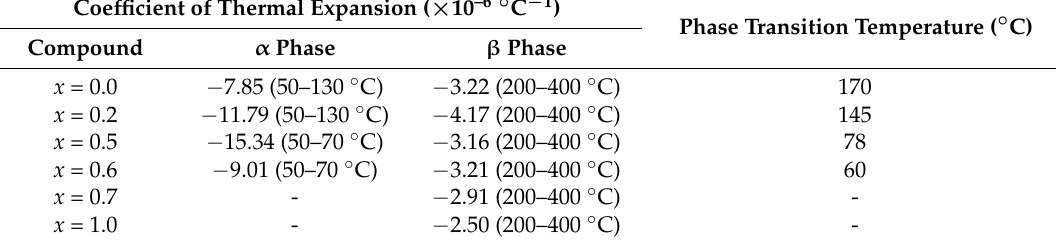
Table 2. Negative thermal expansion (NTE) and phase transition temperature for ZrW 2 − x Mo x O 8